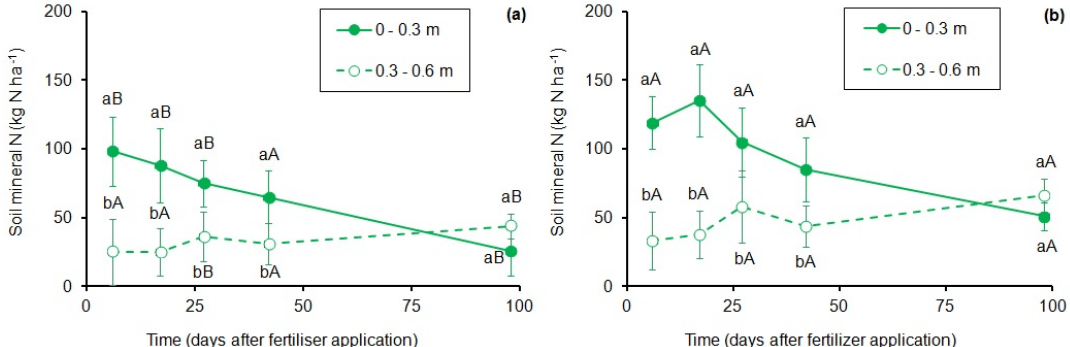
Figure 3. Temporal pattern of soil mineral N content in the ( a ) GS1 treatment (first growing season) and ( b ) GS4 treatment (fourth growing season). Vertical bars indicate the standard deviation (n = 8). For each sampling date, different lower-case letters indicate significant differences between soil layers within each treatment, and different capital letters indicate significant differences between treatments for each soil layer ( p ≤ 0.05).